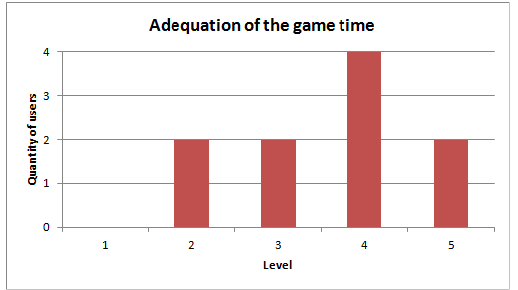
Figure 23. ViMeTGame evaluation question about the timing of the game. Scale: 1 to “Disagree”and 5 to “Fully agree ”. About the game, the volunteers were asked if the level of difficulty was increasing in each level. About 60% of